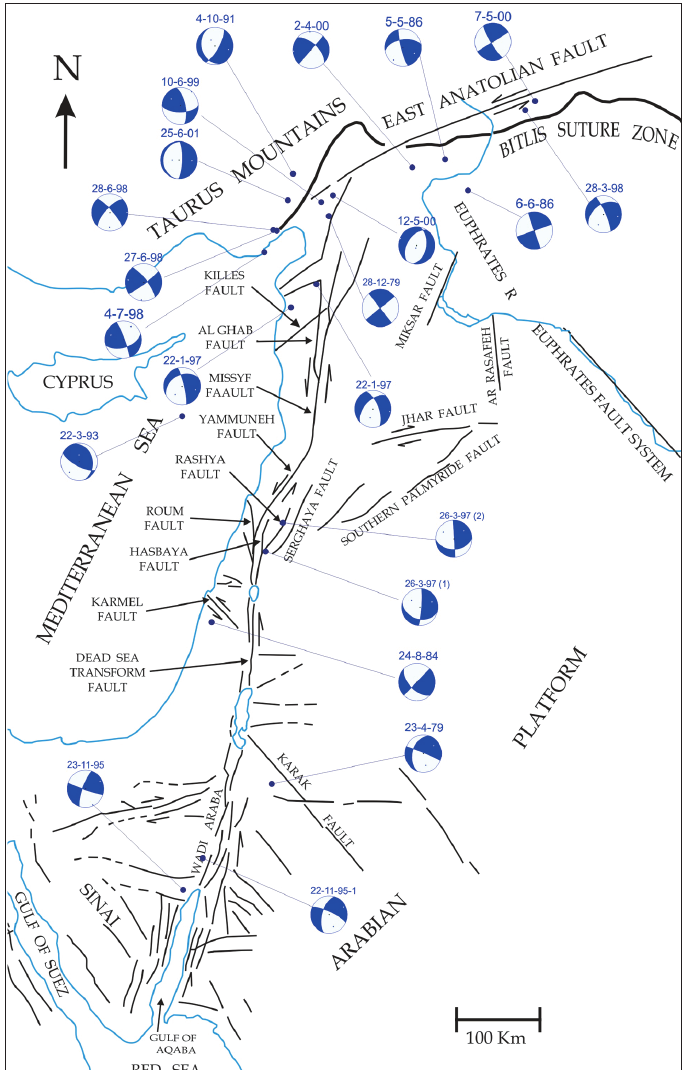
Fig. 1. Summary of major fault zones of the northern Arabian plate (redrawn from Garfunkel et al. , 1981; Barazangi et al. ,